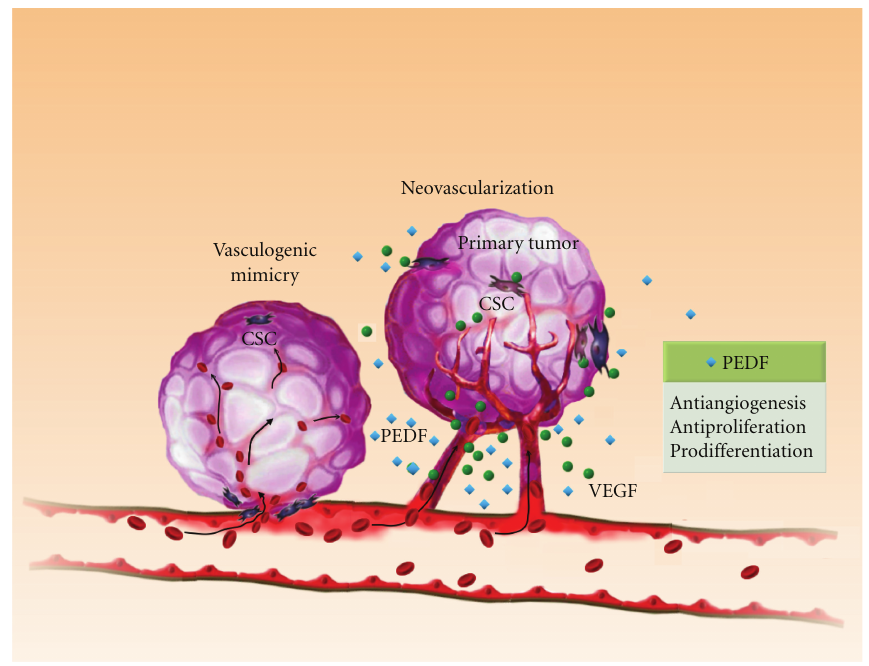
Figure 4: Schematic representation of CSC participation in vasculogenic mimicry and neovascularization initiated by the presence of EPCs. Like in tumor angiogenic sprouting, neovascularization starts with the secretion of proangiogenic factors (such as VEGF) by the tumor under hypoxia. The proangiogenic factors circulate into the bloodstream towards the bone marrow, targeting the release of EPCs. The activated EPCs form a column from the existing blood vessel. PEDF has antitumor properties as an e ff ective antiangiogenic, antiproliferative, and prodi ff erentiation